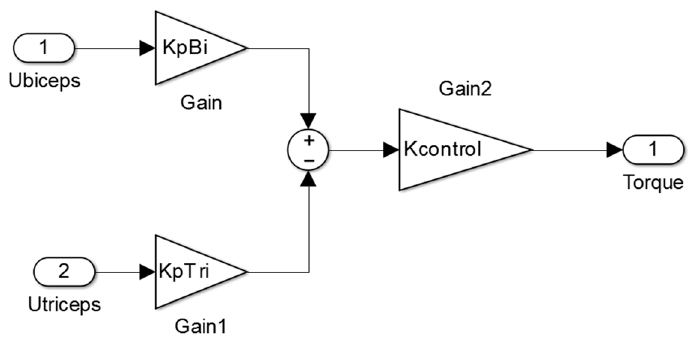
Figure A6. Control law proposal. The optimum K pbi and K ptri values are calculated through the optimization algorithm